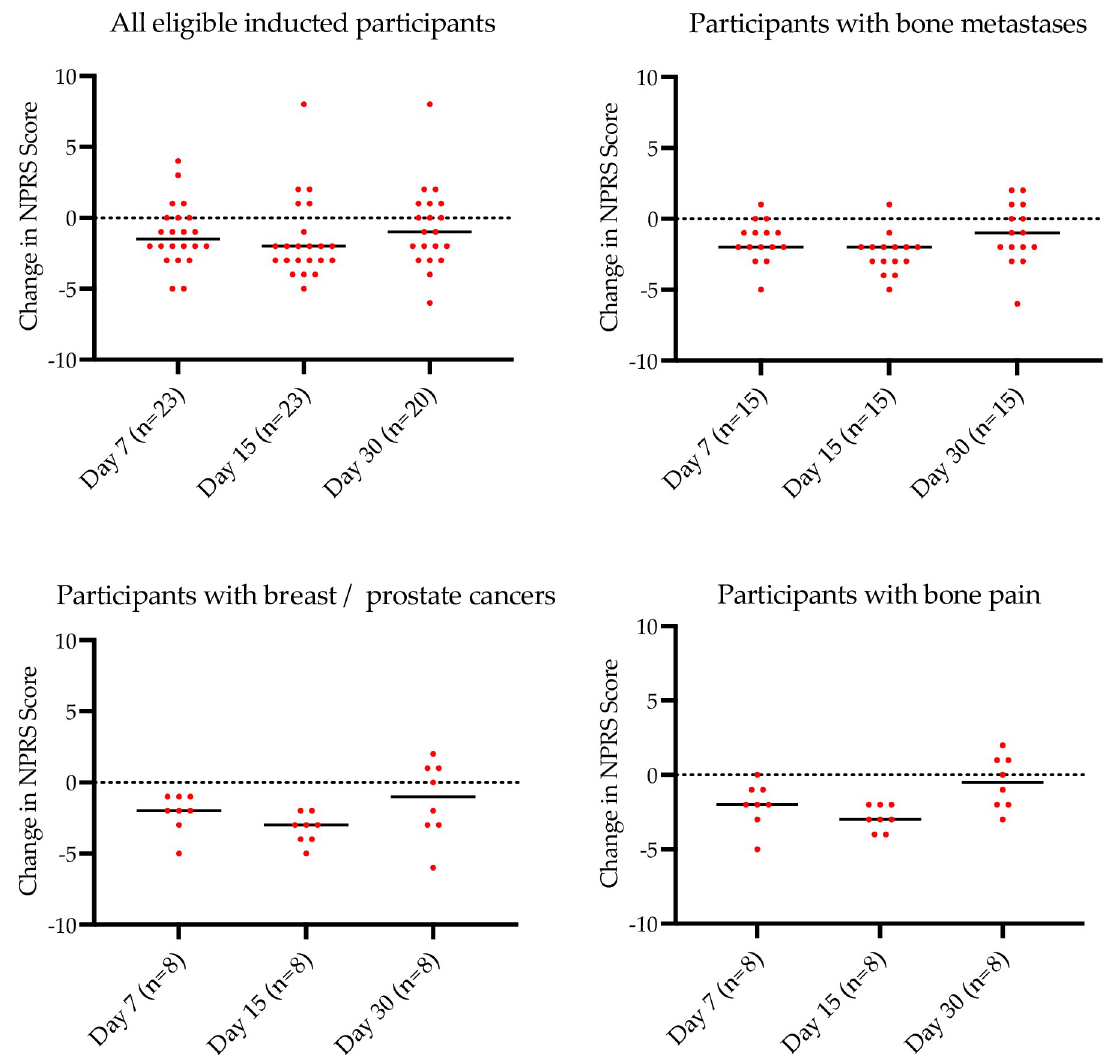
Fig 6. Median change from baseline NPRS scores for all patients, those with bone metastases, those with breast/prostate cancer and those with bone pain. Dots represent individual patient data; the line is median